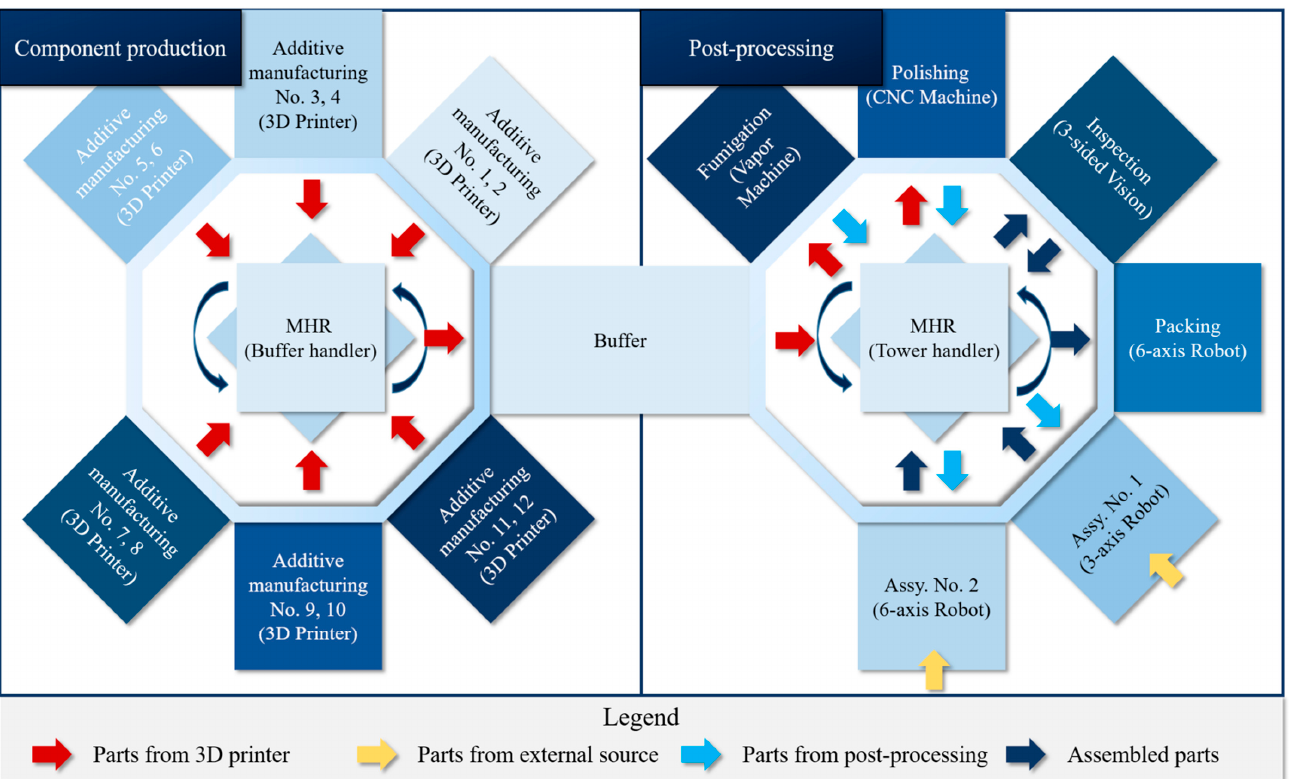
Figure 1. Configuration of a micro smart factory (MSF) [2,5,7,16].